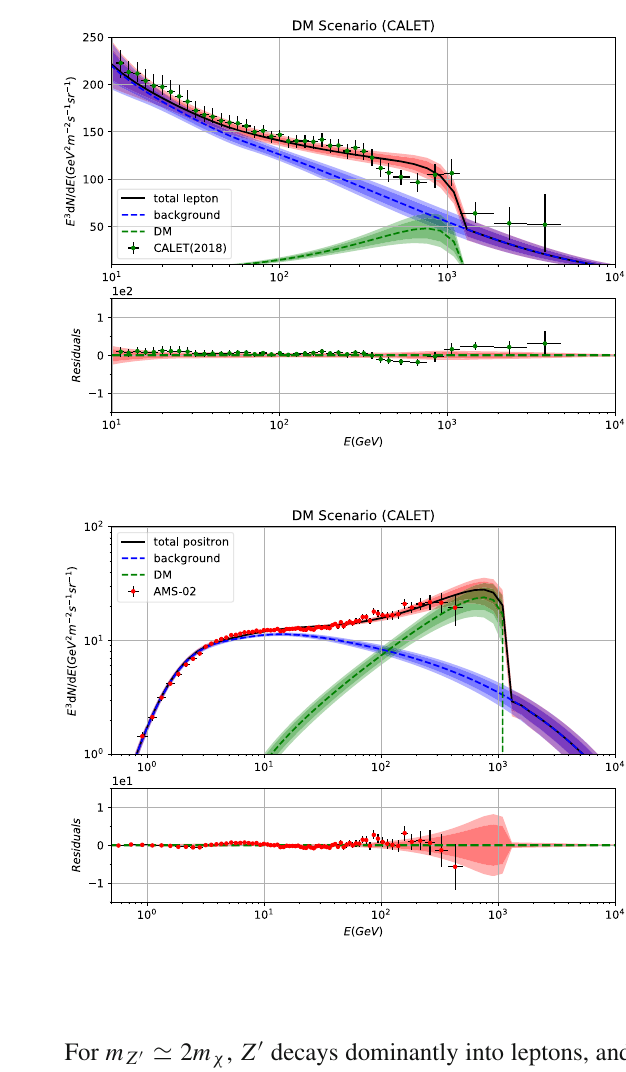
about twice of the χ mass, i.e., M Z (cid:11) (cid:2) 2 m χ , while the Higgs field S and vector-like particles are heavier than M Z (cid:11) . More- c (cid:7) (cid:2) X E E c and will be mixed due to the M V over, i i